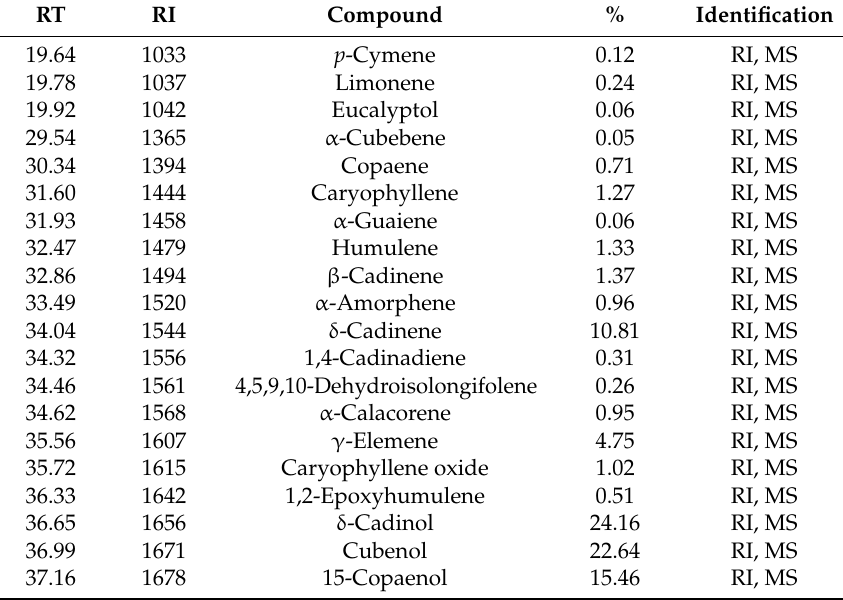
Table 1. Composition of the essential oil from P. uviferum